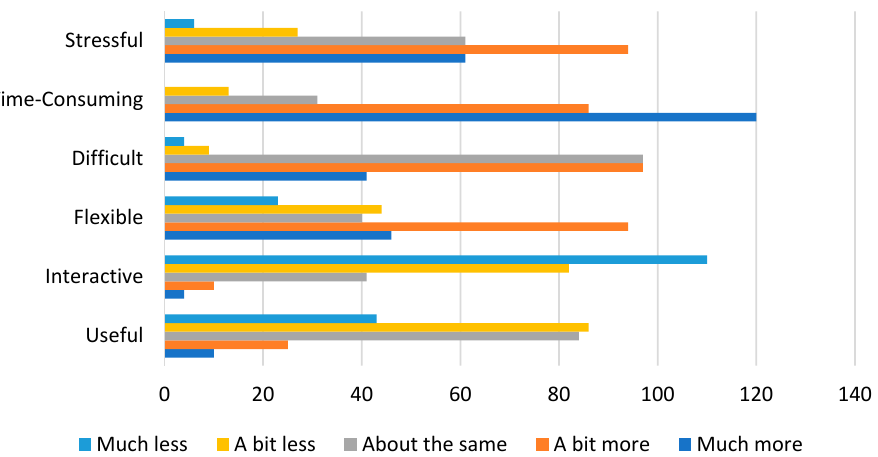
Figure 4. Responses to the survey question: “Comparing your experience of online teaching with your regular teaching, online teaching is...” ( n = 247–250).